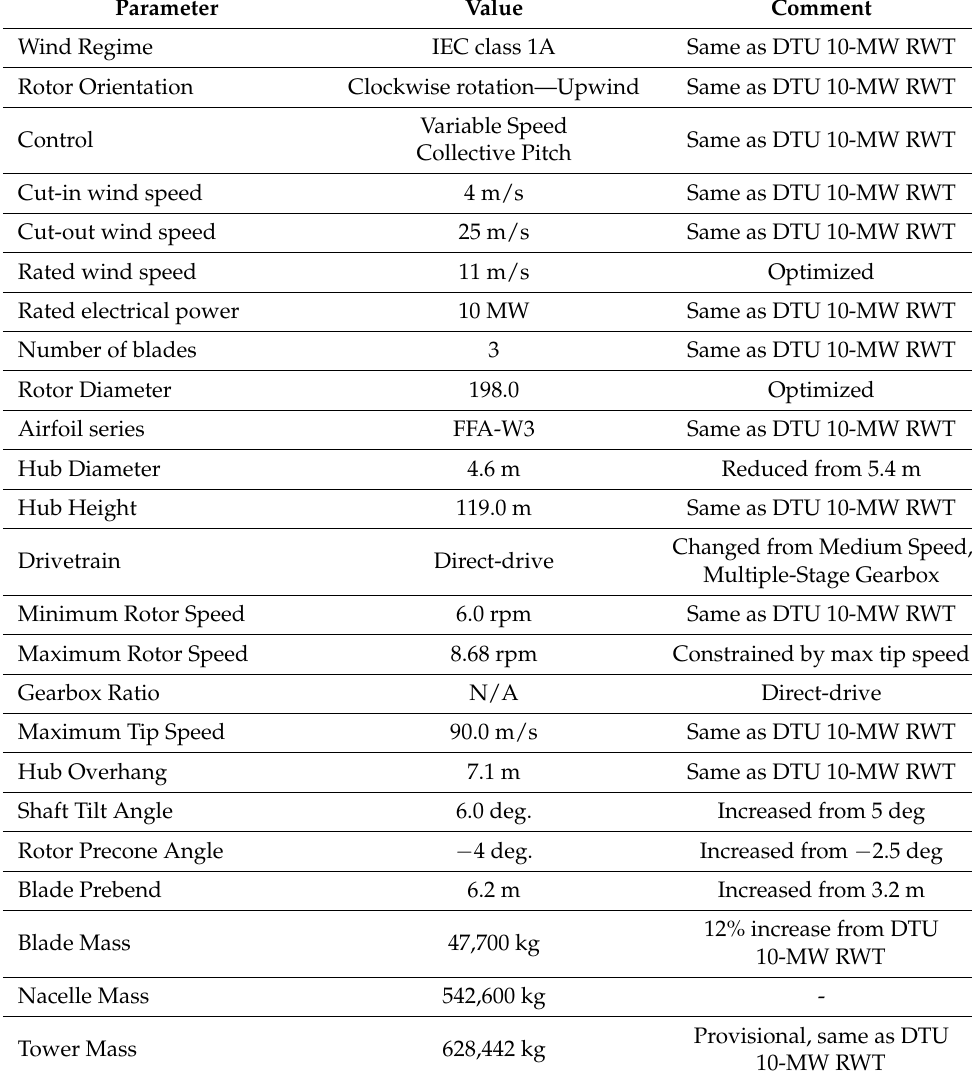
Table 1. Key parameters of the IEA 10-MW compared to the DTU 10-MW RWT.